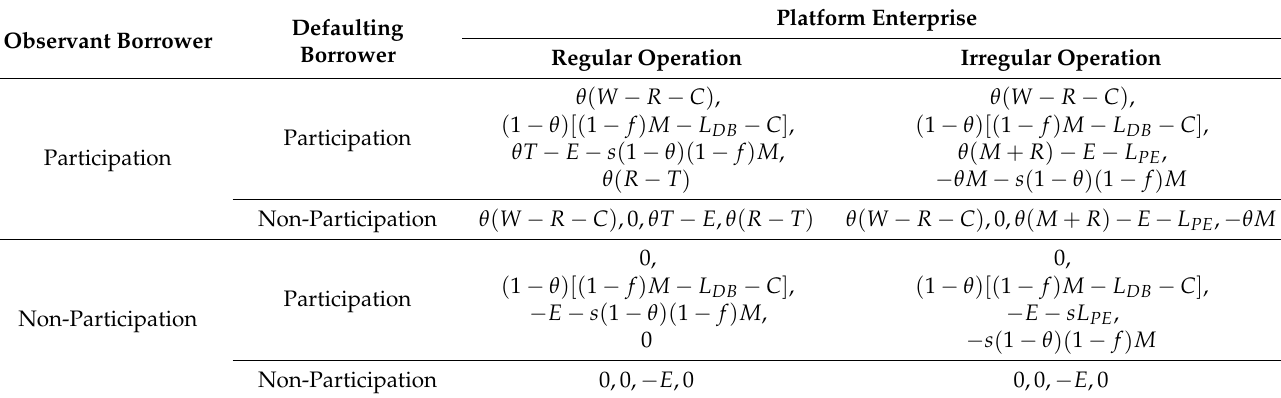
Table 3. Payoff matrix of the peer-to-peer lending platform of scenario 2 (when the investor chooses the IN1 strategy). Observant